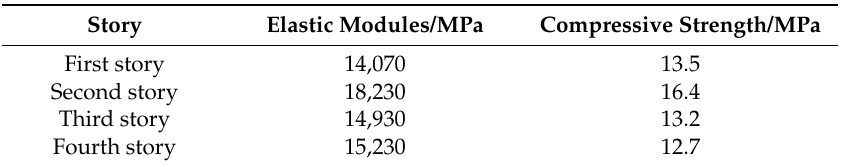
Table 1. Mechanical properties of concrete.